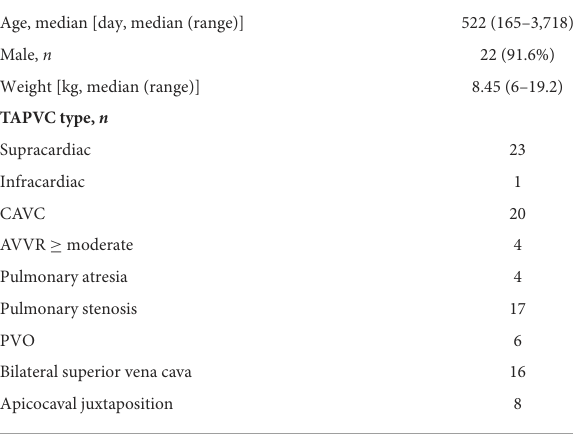
TABLE 2 Procedure for patients with RAI and